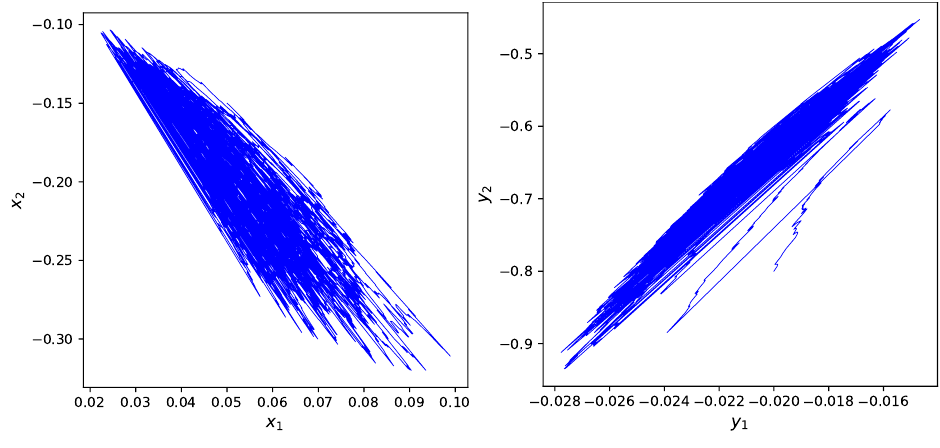
Figure 2. The chaotic attractor of the system (33). The corresponding response system of (35) is given